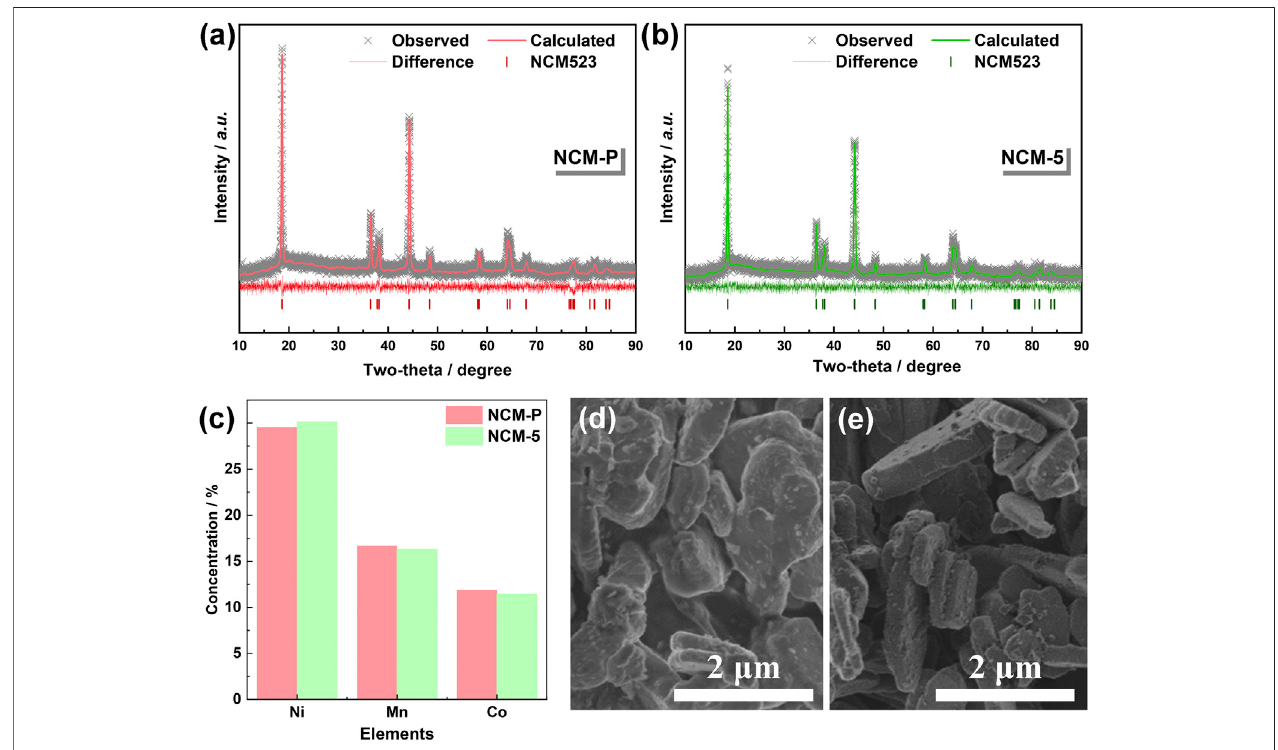
FIGURE 3 | Structural and morphological characters of NCM-P and NCM-5 samples. XRD patterns for NCM-P (A) and NCM-5 (B) , ICP results for NCM-P and NCM-5, and the SEM images for NCM-P (D) and NCM-5 (E) .